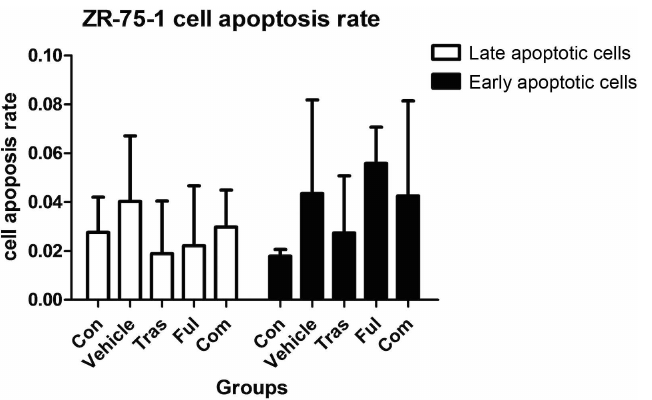
Fig 3. Effects on ZR-75-1 cell apoptosis either untreated or cultured in the presenceof the vehicle or trastuzumab at ED 50 or fulvestrant at ED 50 or both for 72h. Data are representative of at least three independent experiments with similar results. Statistically significantdifferences were not observedin the rate of cell apoptosisbetweentreatment groupsand control groupsin the ZR-75-1 cell line ( P >